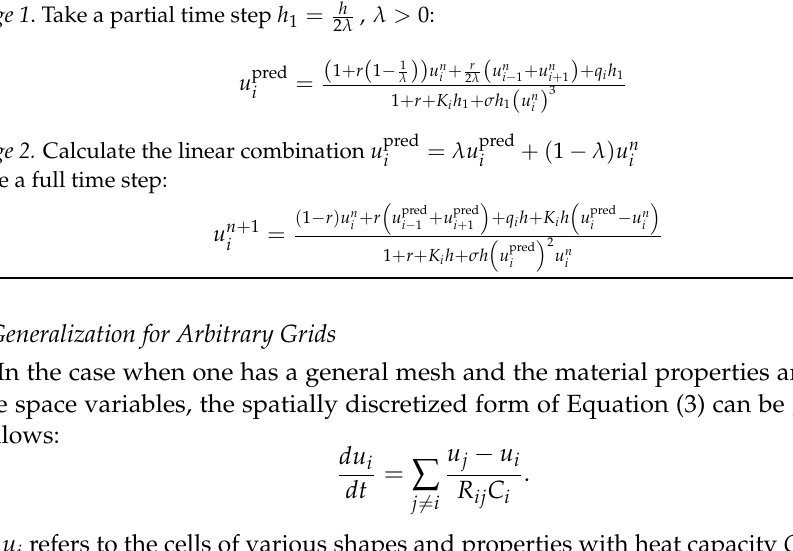
Algorithm 5: (Algorithm 4) For the diffusion-reaction-radiation Equation (1)